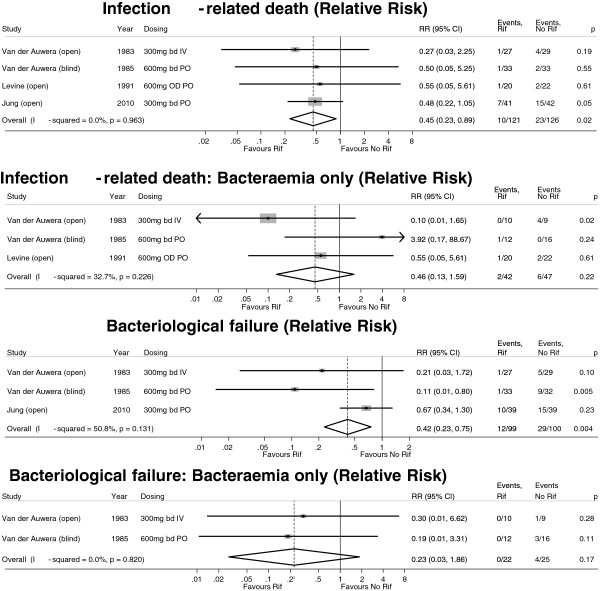
Meta-analysis (fixed effects) of four trials of adjunctive rifampicin for severe S. aureus disease, including bacteraemia.